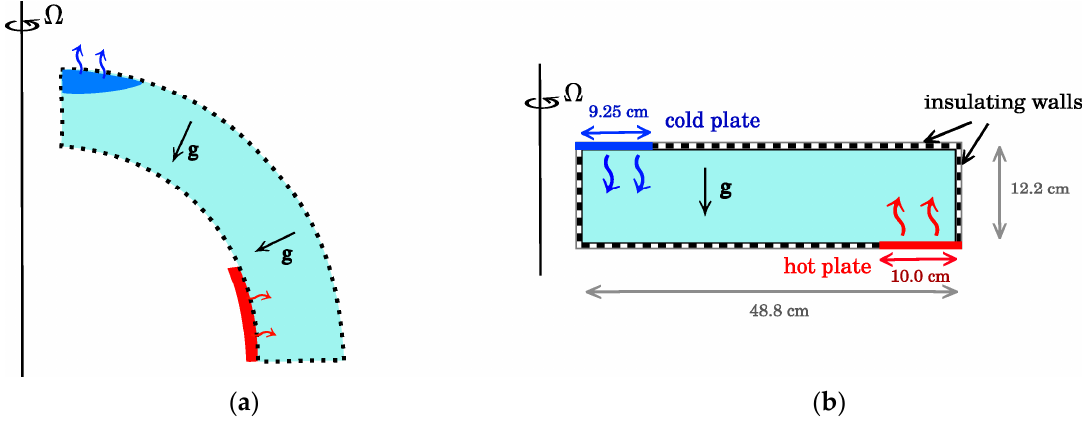
Figure 1. ( a ) Schematic of a whole hemispheric atmosphere. ( b ) Vertical cross-section through the new rotating annulus laboratory experiment with thermal forcing at top and bottom. Ω is the rotation vector and g the gravity vector. The dark blue regions represent the heat sink and the red regions represent the heat